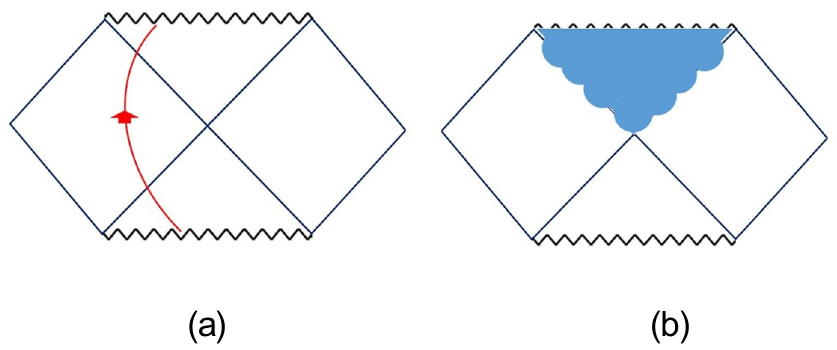
Figure 3 . Folded strings and EPR: a particle that lives in the BH atmosphere on the left (a) is accompanied with a non-perturbative mode that lives on the BH-(cid:12)lling folded string (b). The folded string entangles the left and right sides by having tails on